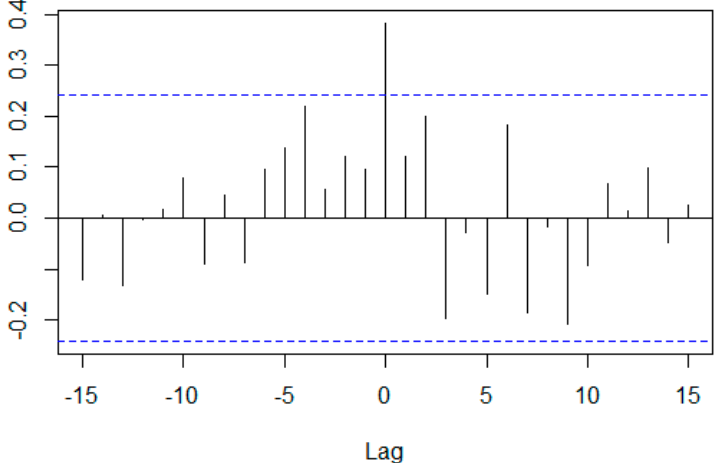
Figure 20. Cross-correlation coefficient between the average BHAR of the camera group and the average BHAR of the display group for Jan 2013–Jul 2018.